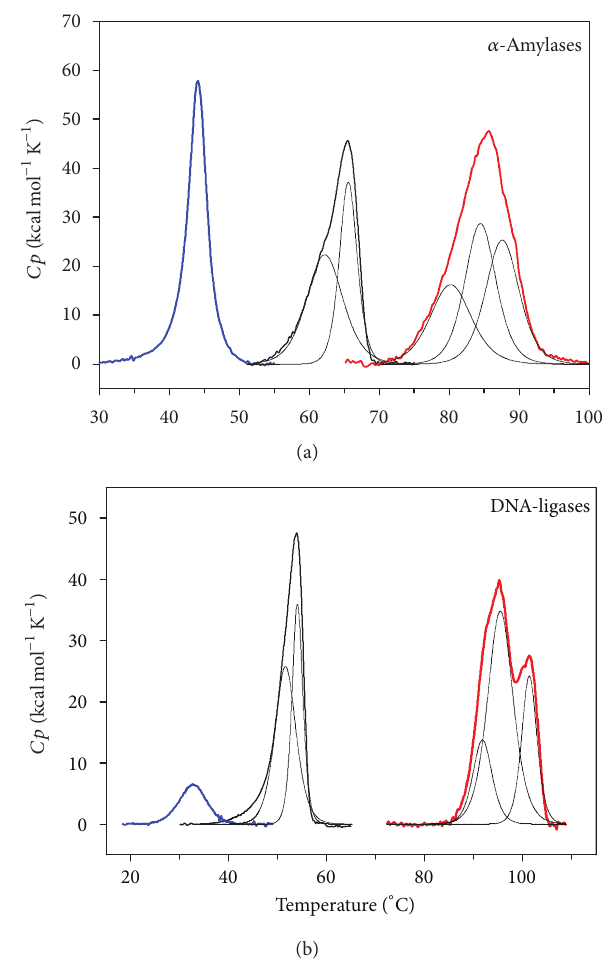
F 9: ermal unfolding of extremophilic proteins. ermo- grams of -amylases and DNA-ligases recorded by differential scan- ning microcalorimetry showing, from le to right on each panel, psychrophilic (blue), mesophilic (black), and (hyper)thermophilic 𝛼𝛼 (red) proteins. e cold-adapted proteins are characterized by (top of the transition) and a lower cal (area under the transition), by a sharp and cooperative transition and by the lack 𝑚𝑚 of stability domains (indicated by thin lines in stable proteins). Δ𝐻𝐻 𝑇𝑇 Adapted from [158, 189].